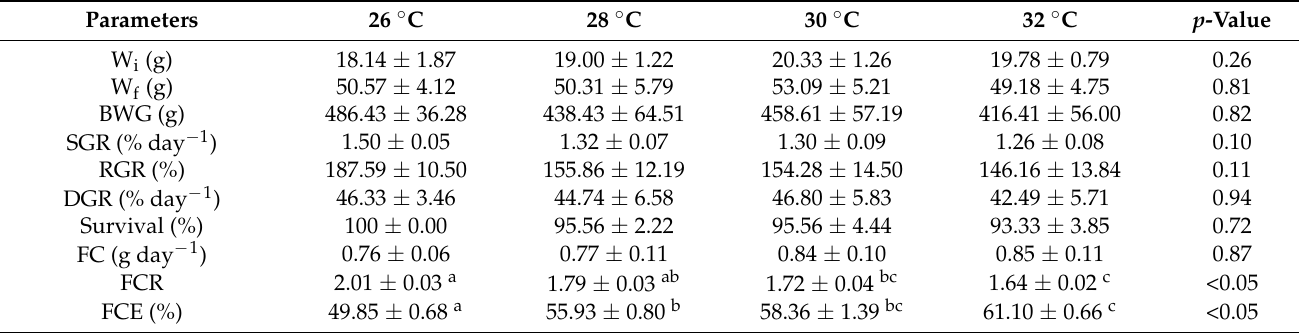
Table 1. Growth performance and feed utilization parameters of C. gariepinus acclimated to 26, 28, 30, and 32 ◦